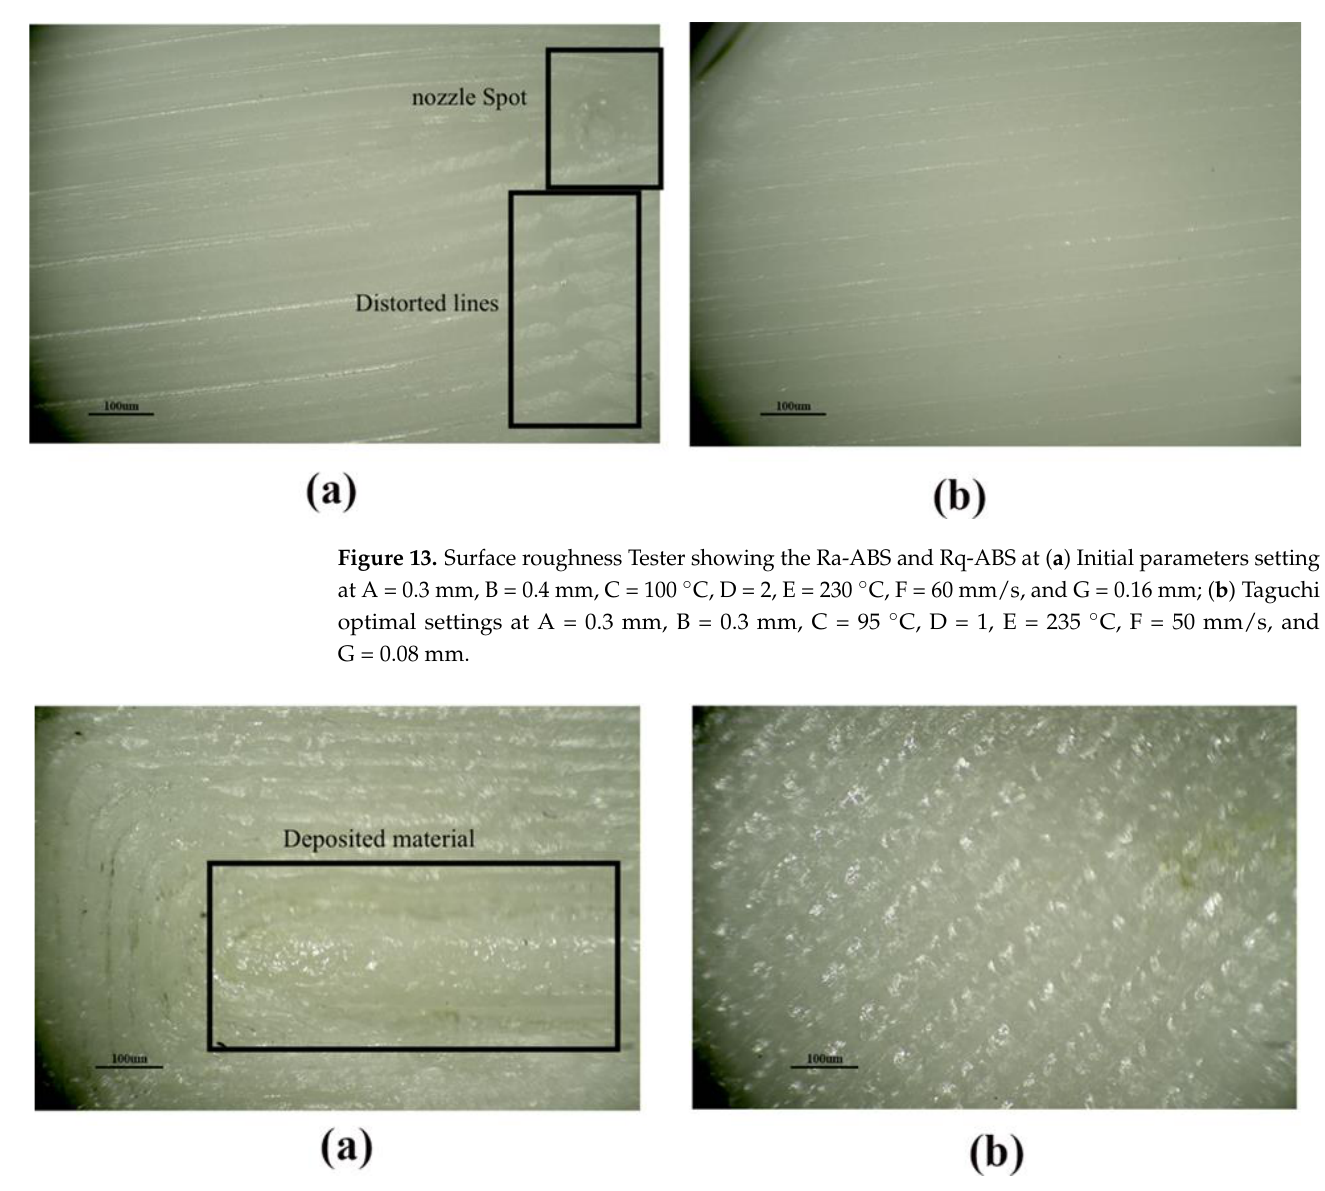
Figure 14. Surface roughness Tester showing the Ra-ABS and Rq-ABS at ( a ) Initial parameters setting at A1= 0.2 mm, A2= 50 mm/s, A3= 255 °C, and A4 = 2; ( b ) Taguchi optimal settings at A1= 0.1 mm, A2 = 40 mm/s, A3 = 260 °C, and A4 = 1.